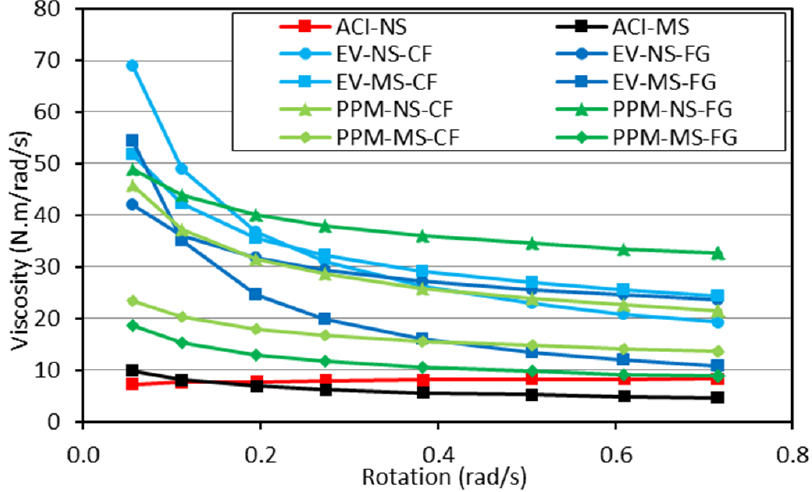
Figure 13. Real viscosity of non-Newtonian mixtures calculated through Herschel–Bulkley model.